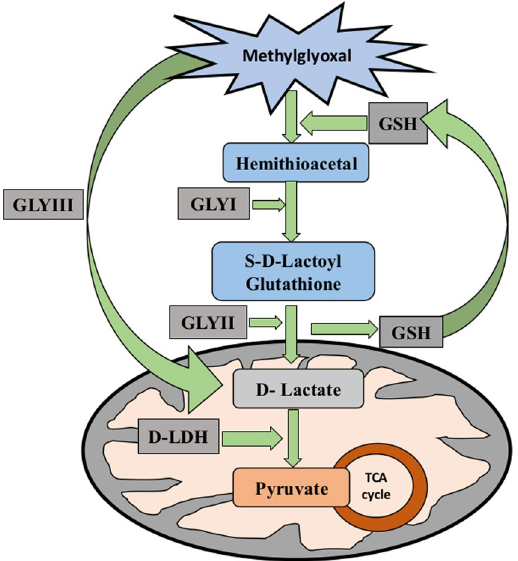
Figure 1. Methylglyoxal detoxification pathway: MG is a toxic metabolite produced in the cell. The detoxification of MG is carried out by various pathways; major one being glyoxalase system that consists of two enzymes, Glyoxalase I and II. Glyoxalase I enzyme converts MG into S-D-lactoyl glutathione which is converted to D-lactate by Glyoxalase II. Glyoxalase III converts MG directly into D-lactate without using any cofactor. Further another enzyme, D-LDH converts this D-lactate into D-pyruvate which goes to TCA cycle. Thus, the toxic MG is diverted to produce energy for the